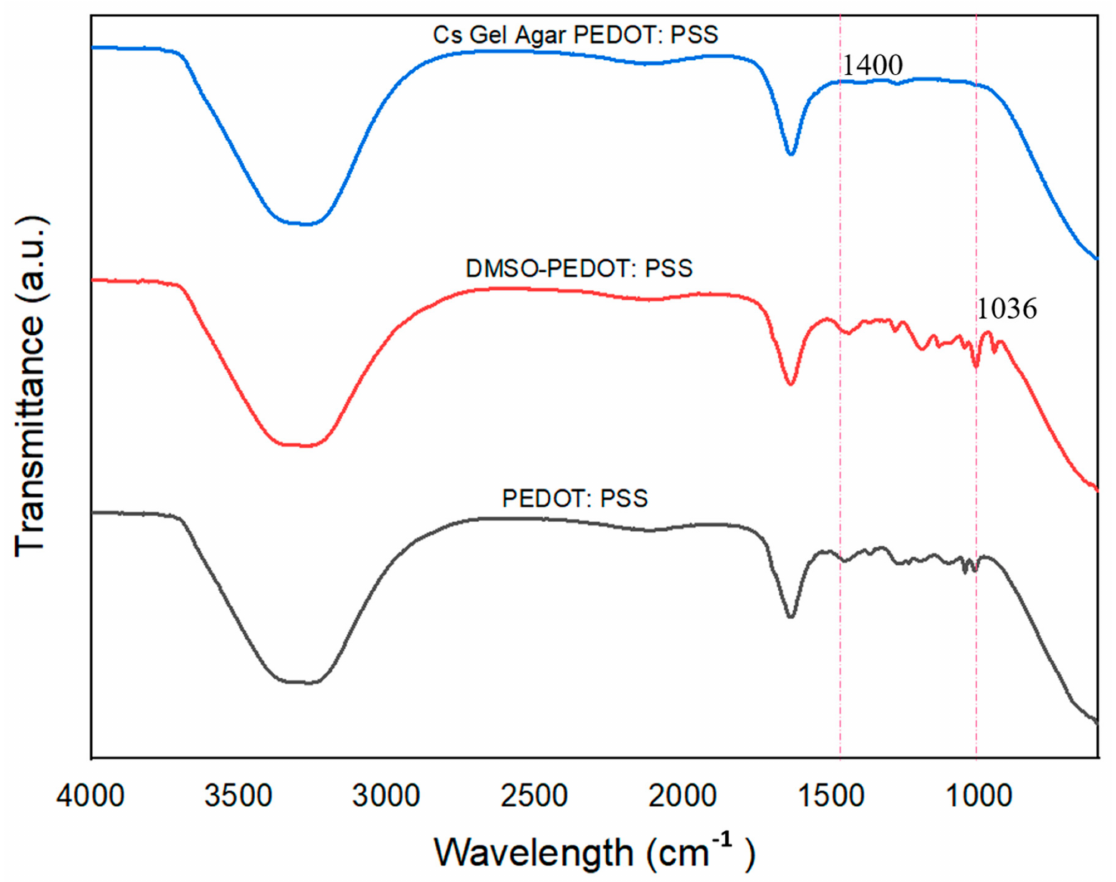
Figure 10. ( a ) Crosslinking interaction between chitosan and glutaraldehyde; ( b ) crosslinking interaction between gelatin and glutaraldehyde; and ( c ) crosslinking interaction between chitosan, glutaraldehyde and gelatin.